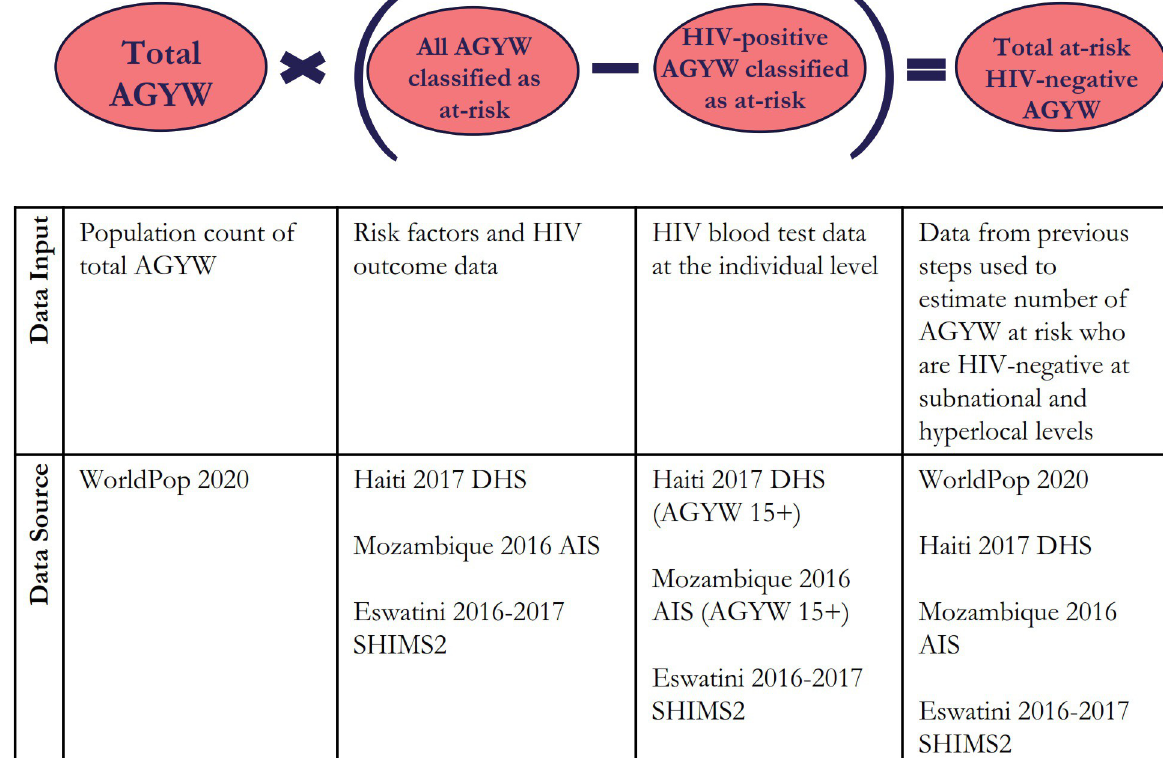
PLOS ONE | https://doi.org/10.1371/journal.pone.0261520 December17,